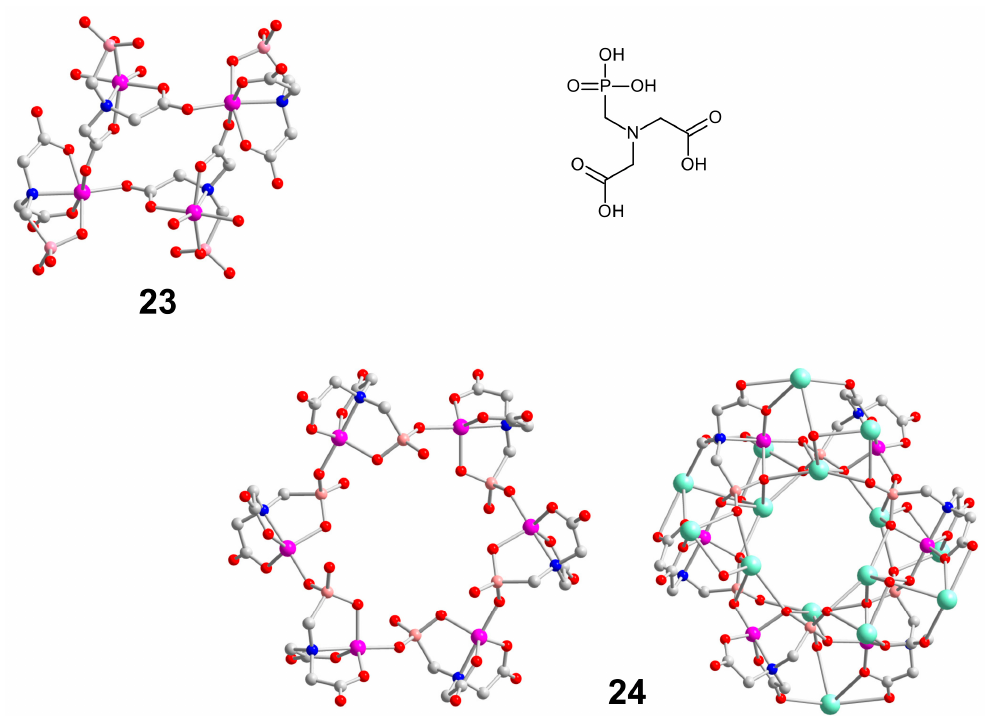
Figure 8. Structure of complexes 23 and 24 . Color scheme: Co, pink; K, pale green; O, red; N, blue; P, pale pink. Structure 24 is presented in two views, without (left) and with (right) nearest potassium atoms.